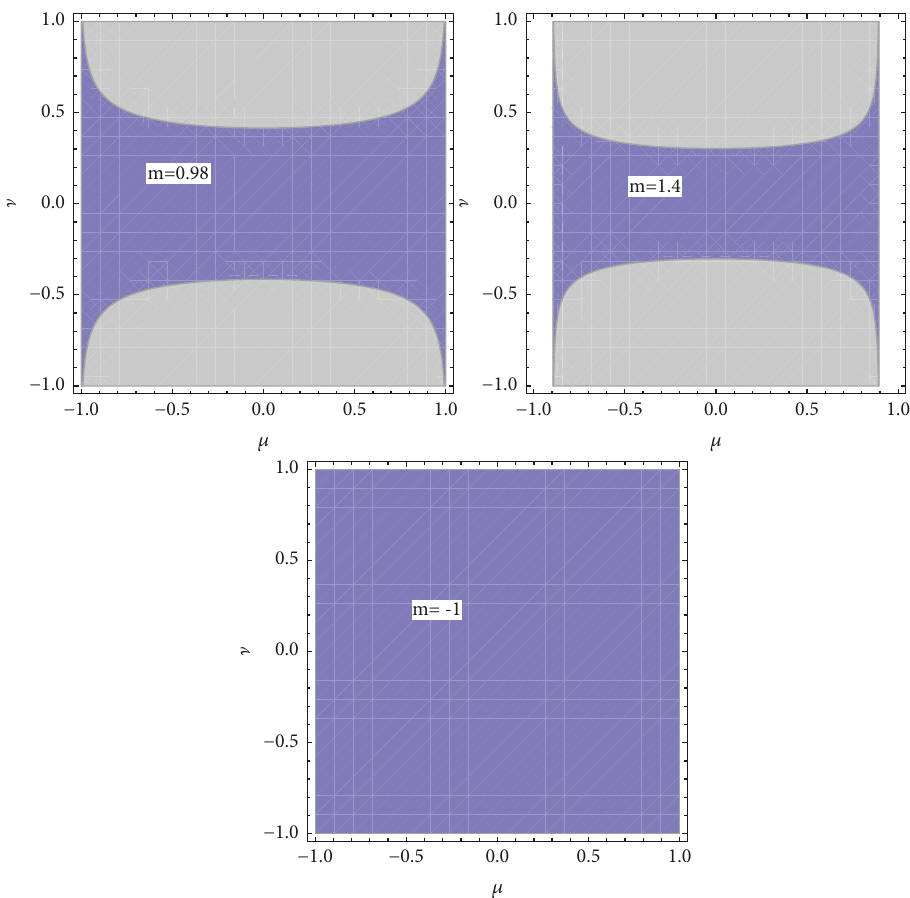
Figure 6: Plots of qualitative phase space analysis for power-law scale factor with tachyon coupled matter.